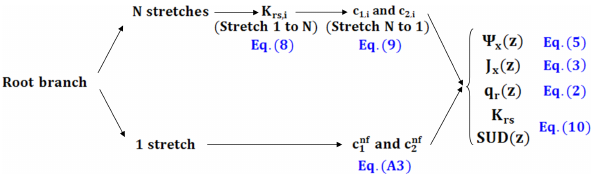
Figure 3. Flowchart of the water flow equation resolution in roots with heterogeneous hydraulic